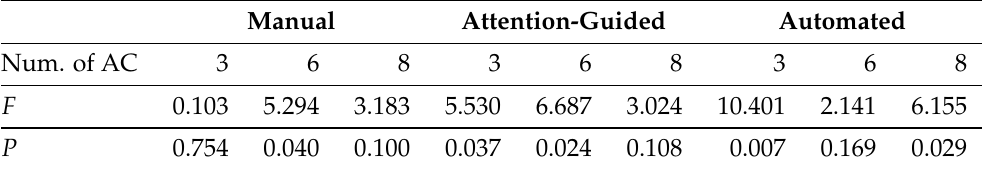
Table 8. Statistical tests on average saccade between students and ATC professionals. Manual Attention-Guided